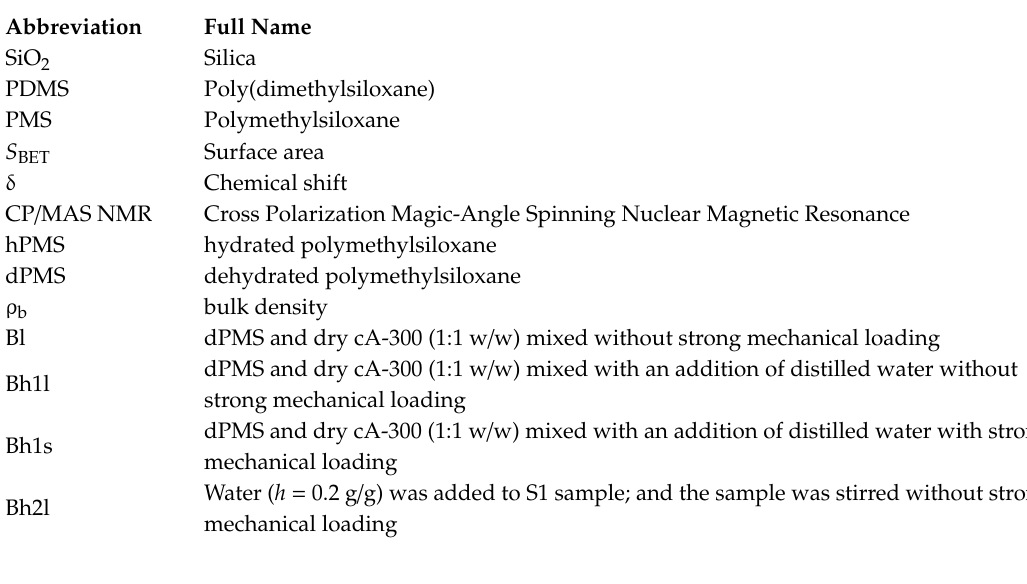
Figure S1: TEM images of (a) Bl, (b) Bh1l, (c) Bh1s, (d) Bh2l, (e) Bh2s, (f) Adl, (g) Pdl, and (h) Phdl (scale bar 100 nm (a–d,h) and 200 nm (e,f)), Figure S2: TEM image of Bh2l, Figure S3: SEM images of Bl, (b) Bh1l, (c) Bh1s, (d) Bh2l, (e) Bh2s, (f) Adl, (g) Pdl, and (h) Phdl (scale bar 1 µ m), Figure S4: Particle size distributions